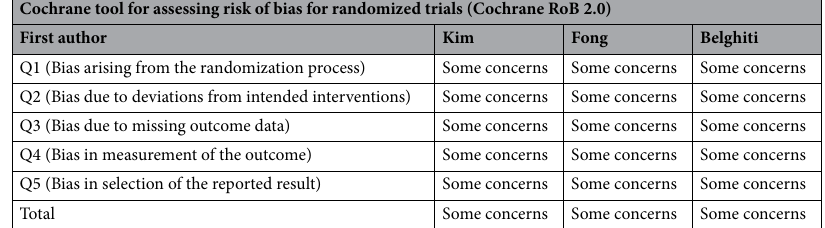
Table 2. Risk of bias assessment for included randomized controlled trials. Q1 Was allocation sequence concealed? Q2 Participant and personal aware of intervention? Q3 Were outcome data available for all, or nearly all, participants randomized? Q4 Were outcomes assessors aware of the intervention received by study participants? Q5 reported data selected, on the basis of the results, from multiple outcomes or multiple analyses of the data?